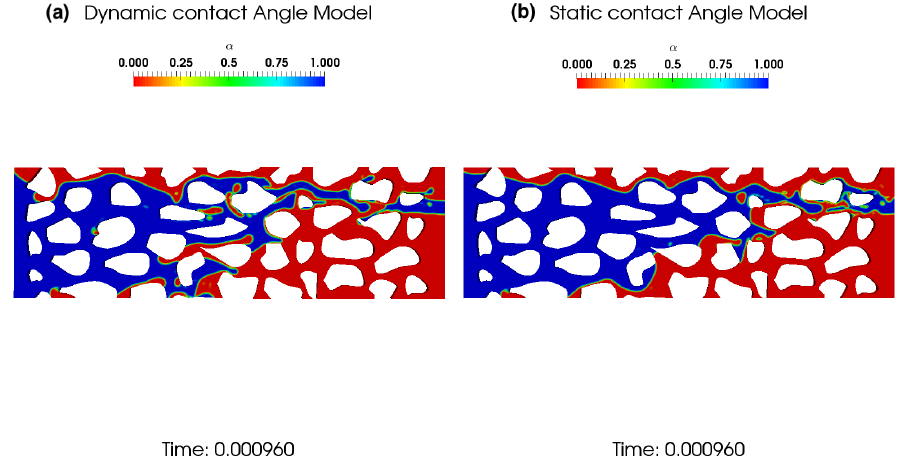
Figure 7. A comparative simulation of the effect of dynamic ( a ) and the static ( b ) contact